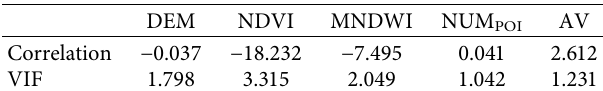
Table 5: The regression coefficients between LST and driving factors.